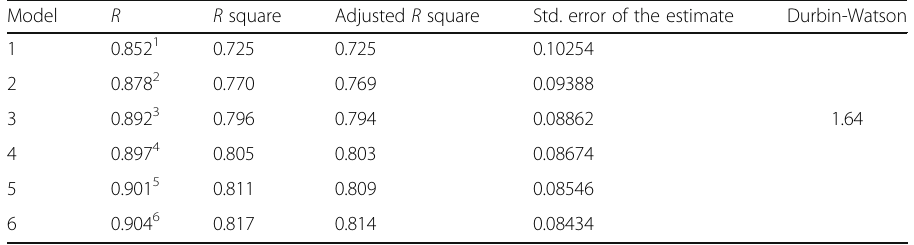
Table 5 Summary of factors influencing consumers ’ perception of health benefits of organic vegetables using Stepwise Multiple Linear